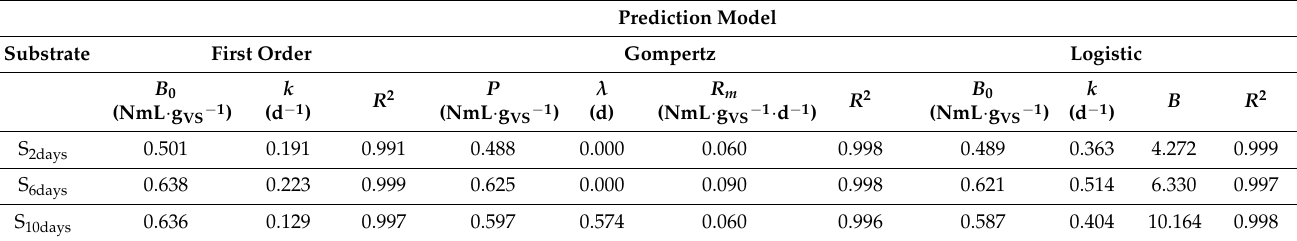
Table 5. Parameters of the prediction models to estimate the OFMSW methane